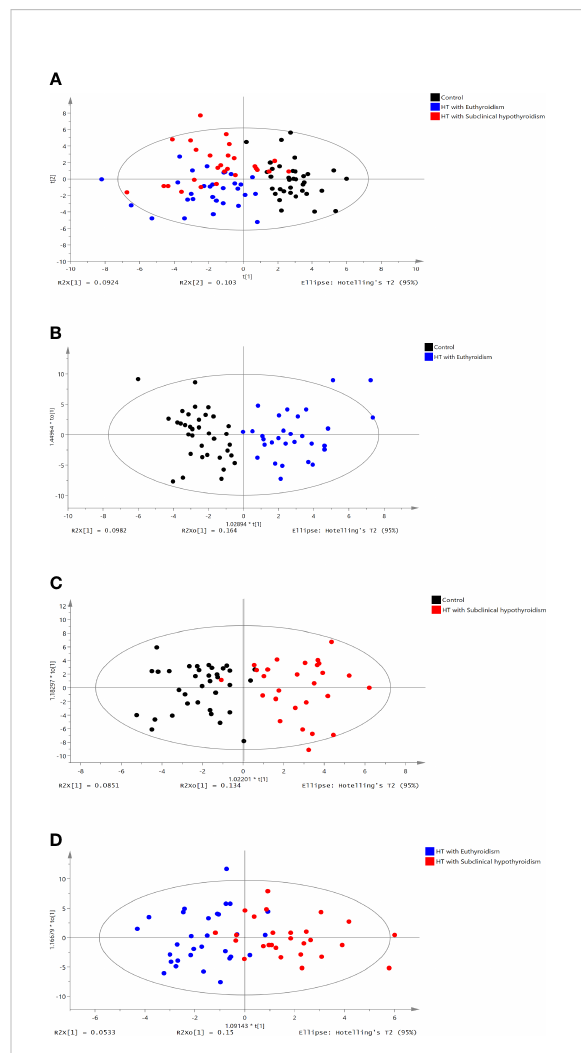
FIGURE 1 PLS-DA score plot of the control vs HT with euthyroidism,HT with subclinical hypothyroidism groups. (A) PLS-DA score plot of three groups (R2X =0.195, R2Y = 0.44, Q2 = 0.281). (B) OPLS- DA score plot of the control group vs. the HT with euthyroidism group (R2X =0.262, R2Y = 0.756, Q2 = 0.641). (C) OPLS-DA score plot of the control vs HT with subclinical hypothyroidism group (R2X=0.203, R2Y=0.56, Q2 = 0.233). (D) OPLS-DA score plot of HT with euthyroidism group vs. HT with subclinical hypothyroidism group (R2X =0.203, R2Y = 0.563, Q2 = 0.233). The t [1] and t [2] values in the fi gures represent the scores of each sample in principal components 1 and 2, respectively. Each dot on the plot represents a sample in the corresponding